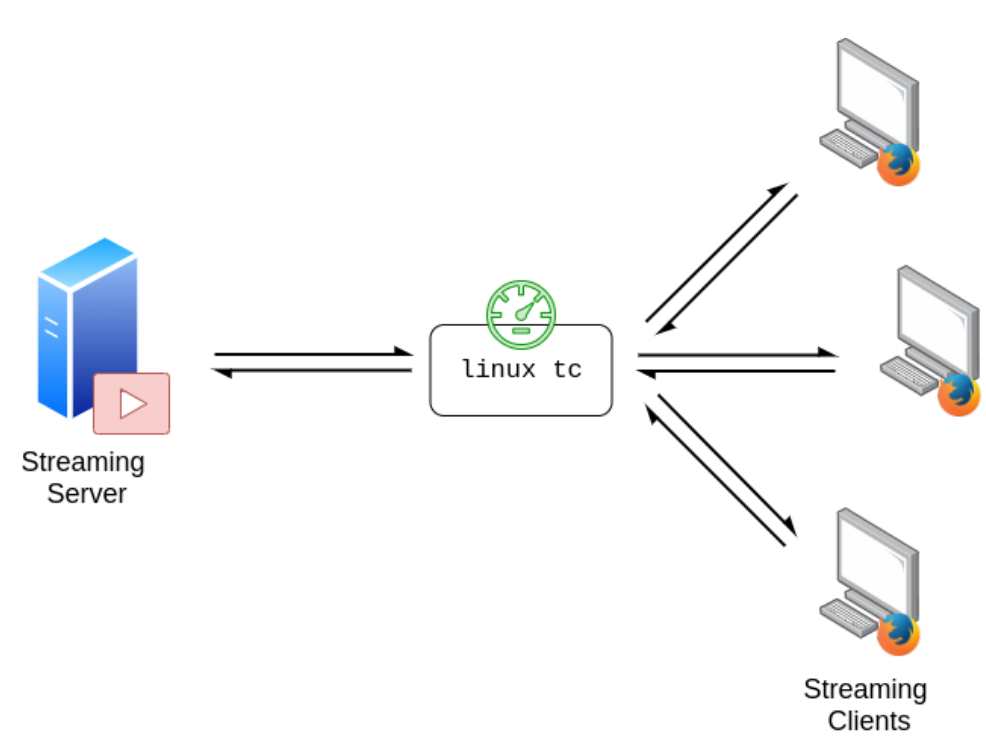
Figure 2. Experimental